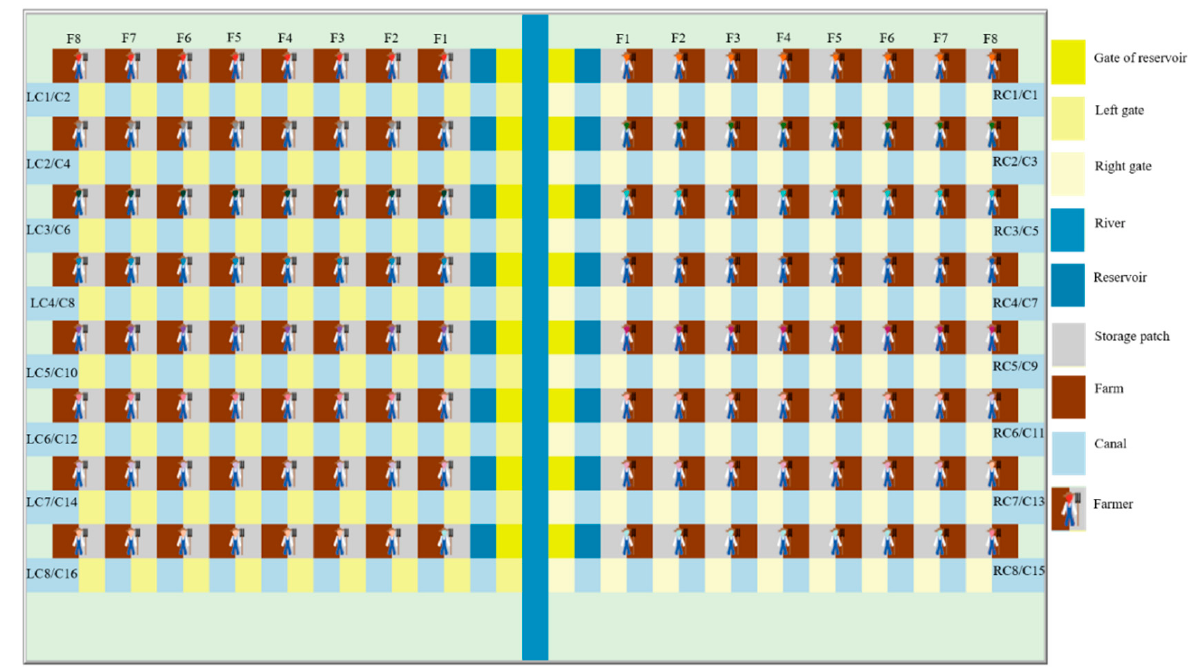
Figure 2. The layout of the artificial irrigation system. Note: RC—the right canal, LC—the left canals, C—canals, F—farmers, number—the ID of each farmer and canal, the higher the number, the more downstream the farmer/canal.